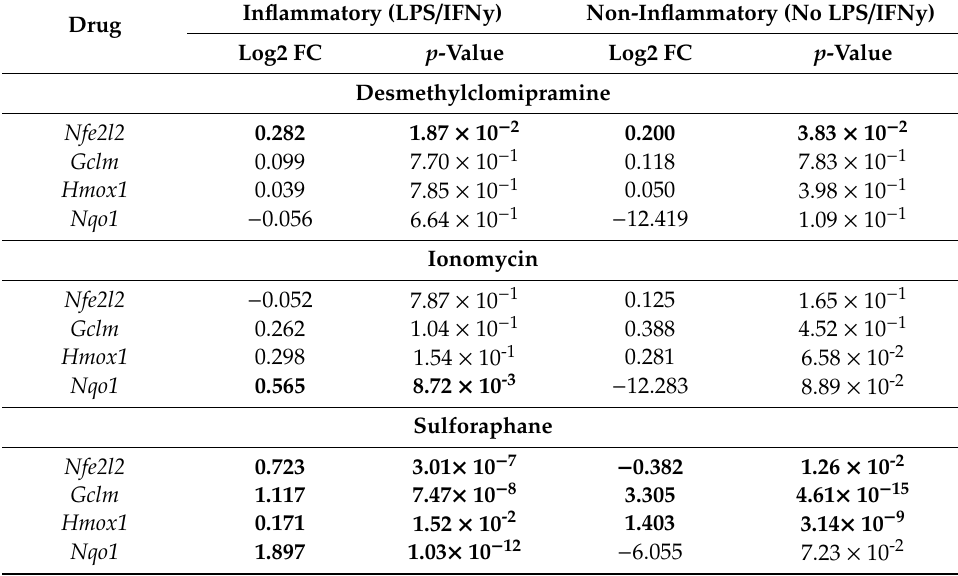
Table 3. Target engagements measured as a gene expression of Nfe2l2 , Gclm , Hmox1 and Nqo1 after 16-h treatment with desmethylclomipramine, ionomycin or sulforaphane under LPS / IFNy-induced inflammatory or non-inflammatory conditions in BV2-microglia cell